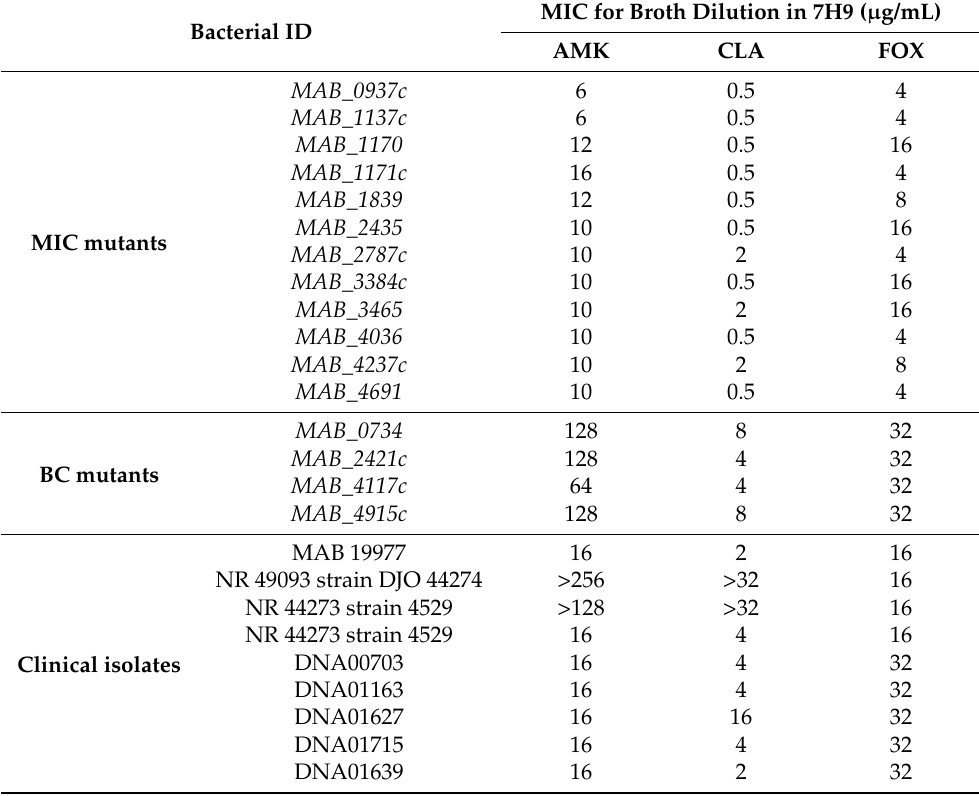
Table 4. The antibiotic susceptibility of MAB gene knockout mutants associated with the surface transport systems and MAB clinical